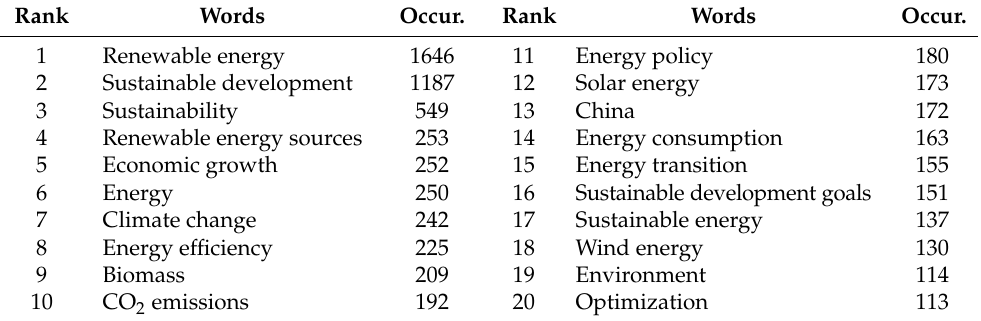
Table 9. Most frequent